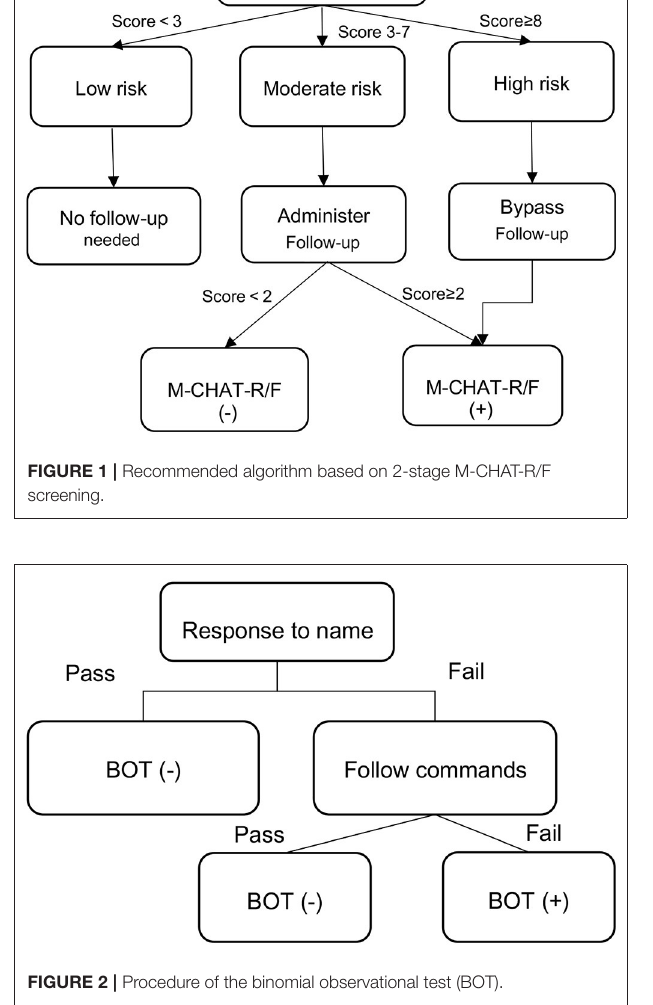
the child could not follow either command, she/he failed the